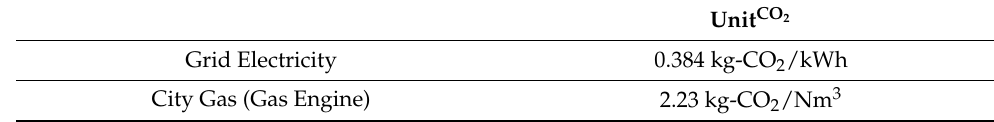
Table 3. Unit CO 2 emissions due to grid and gas engine